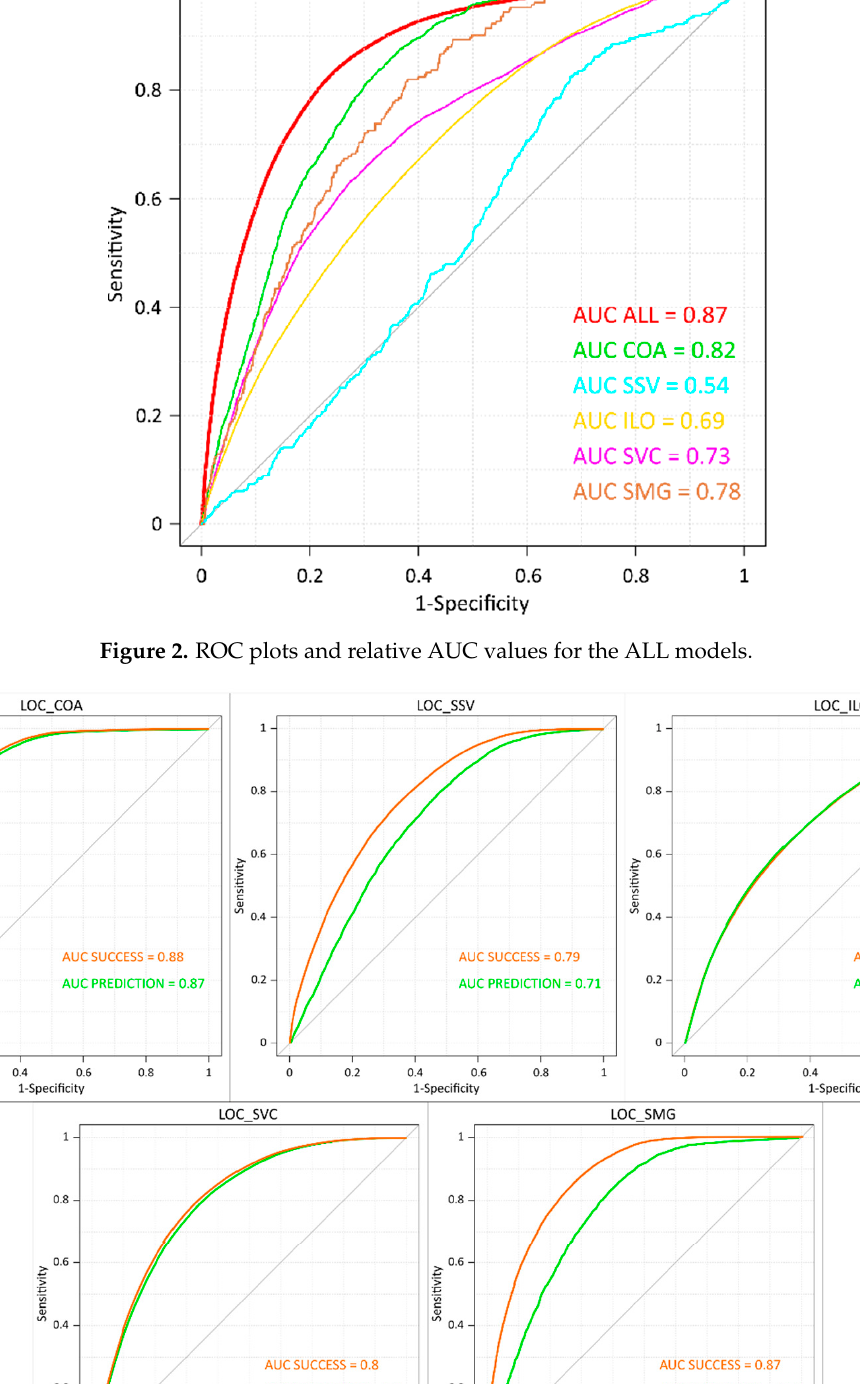
Figure 3. ROC plots and relative AUC values for the LOC models.